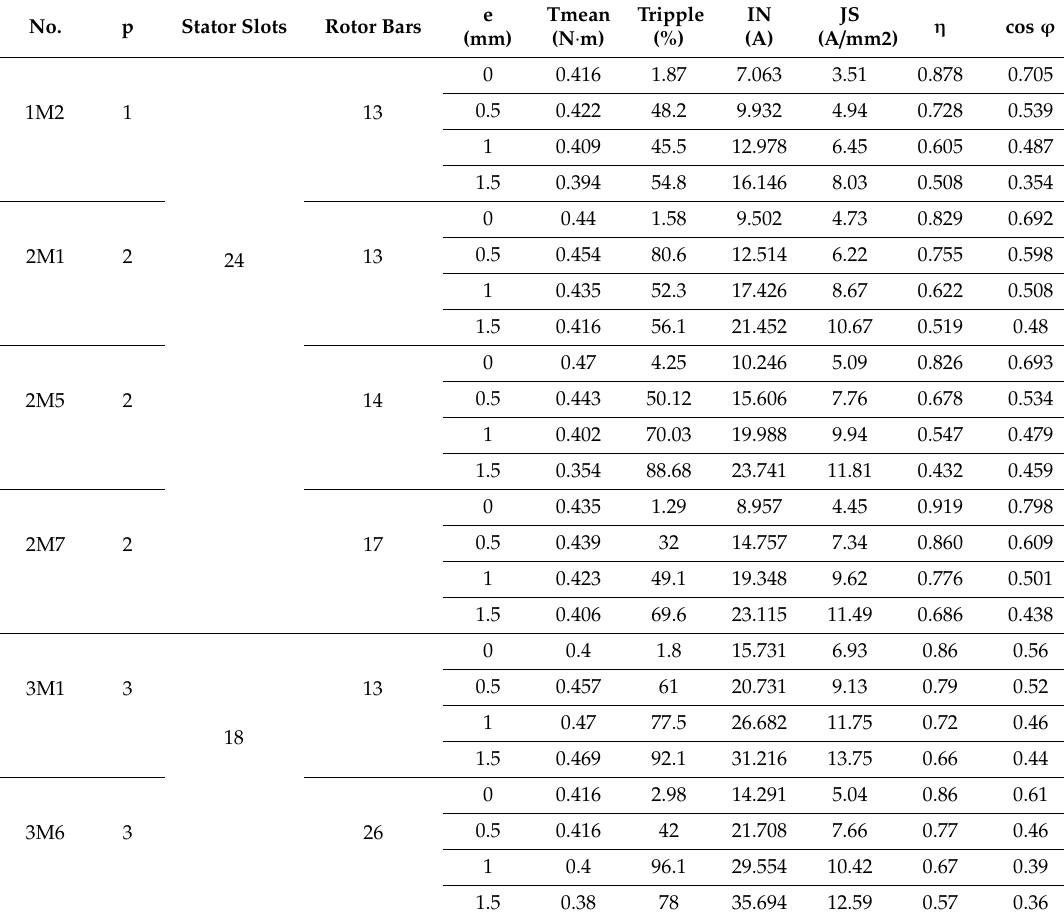
Table 4. Parameters of the best model for each topology for various values of the eccentricity.